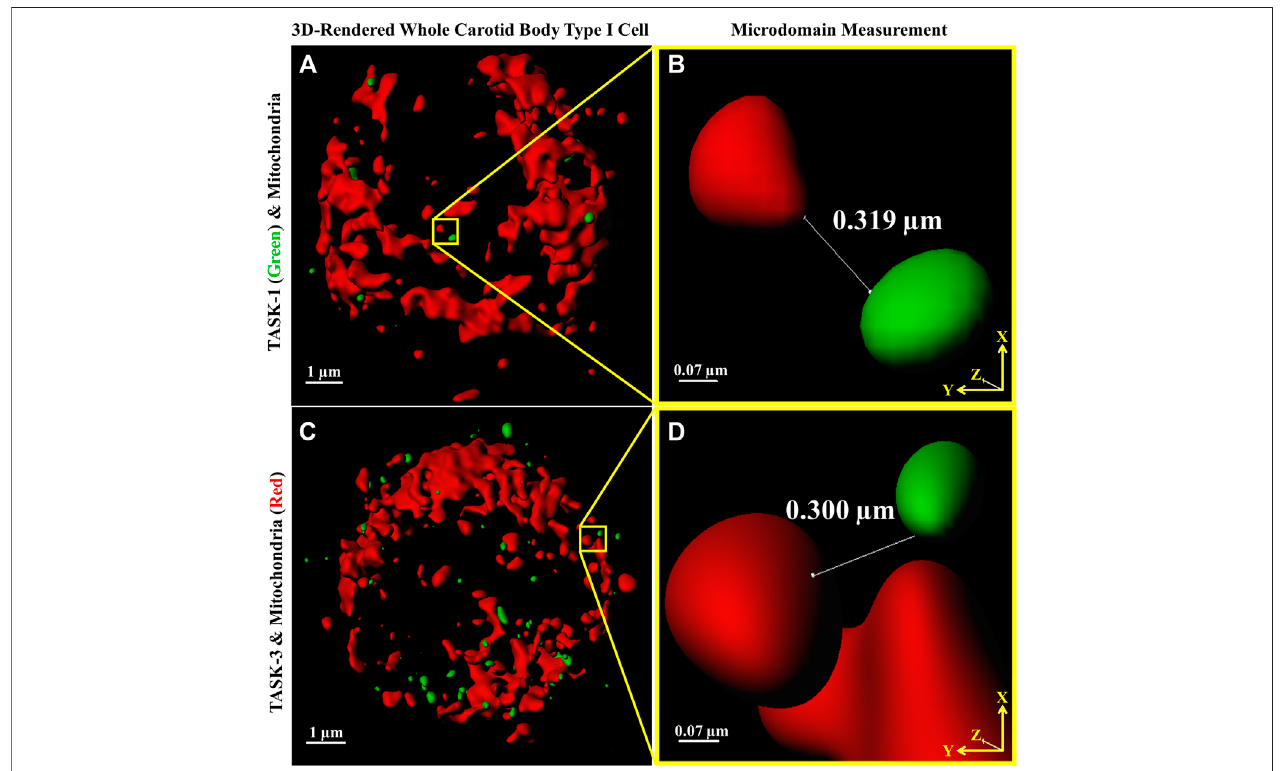
FIGURE 1 | Distances between Carotid Body Type I cell (A,C) fl uorescently antibody-labeled mitochondria (red) and TASK-1 (A & B); green and TASK-3 (C & D); green potassium ion channels were measured providing fi rst quantitative evidence of microdomains. Software-provided tools (Imaris) de fi ned line end-points (shown in B , D ) as an intersection of an x - y axis oriented line with MIP-rendered voxel surface boundaries. Images A and C are 3D reconstructions of whole Type I cells, the nuclei are not stained.